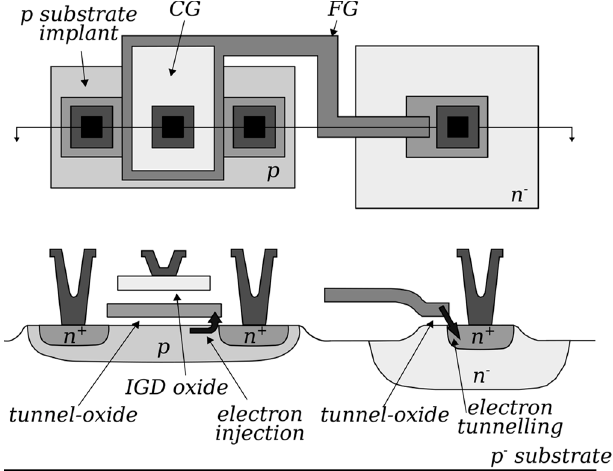
Figure 6. Top view ( up ) and side view ( down ) of the synaptic transistor. Physical mechanisms exploited for program (electron injection) and erase (electron tunneling) are highlighted too. Adapted with permission from [48]. Copyright 1997, IEEE.